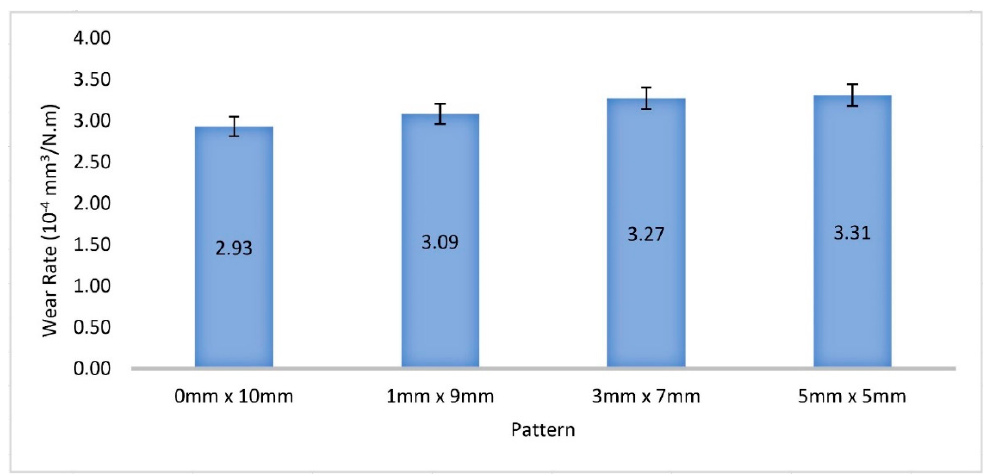
Figure 12. Wear rates of Ti-6Al-4V ELI alloy discs tested over 5000 cycles against alumina balls using Ringer’s solution as lubricant.